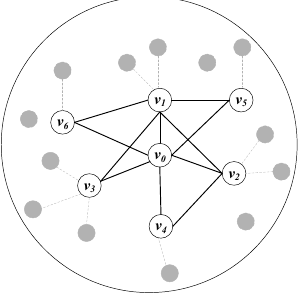
Figure 5. Small Network Graph